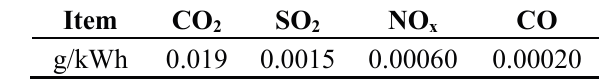
Table 8. Direct emissions generated by biomass power plant operations.